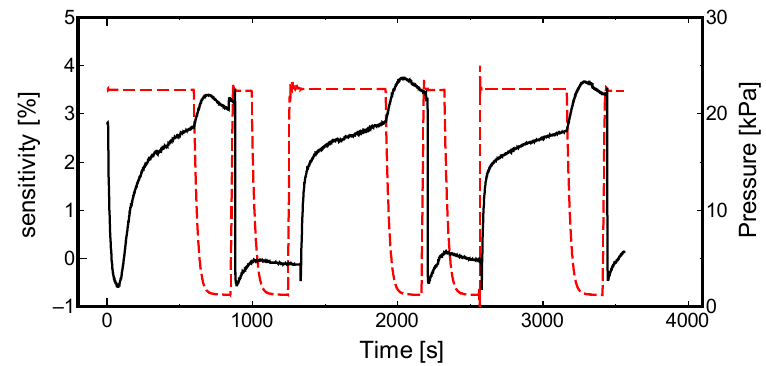
◦ C) sensitivity Figure 7. Sample 213-1 summer (more than 25 °C) sensitivity measurement. Figure 7. Sample 213-1 summer (more than 25 Figure 7. Sample 213-1 summer (more than 25 °C) sensitivity measurement.